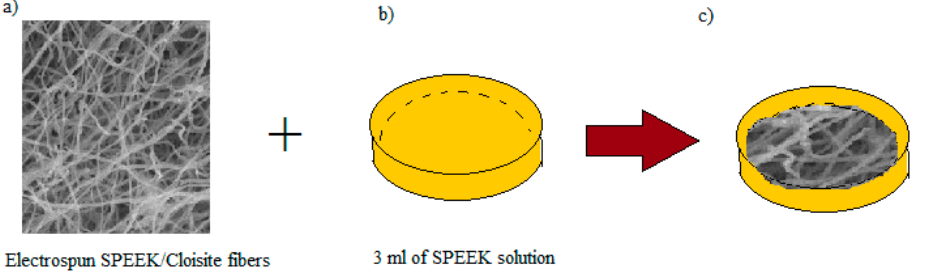
Table 1. The designation of membrane samples.